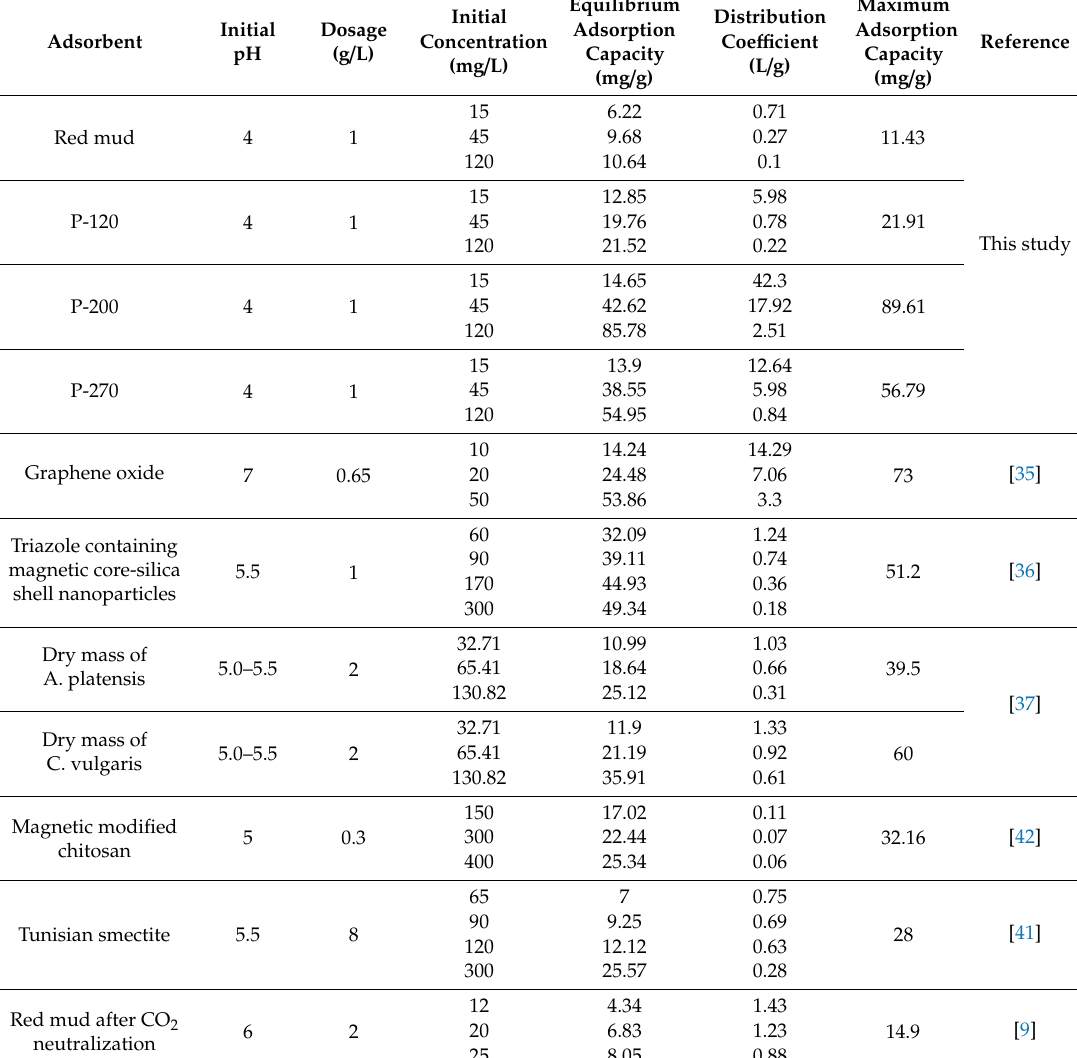
Figure 8. ( A ) K d and ( B ) K d medium values of Zn2+ on the red mud, P-120, P-200, and P-270. Table 2. Comparison of distribution coefficients of Zn 2+ on the red mud, P-120, P-200, P-270, and other adsorbents.